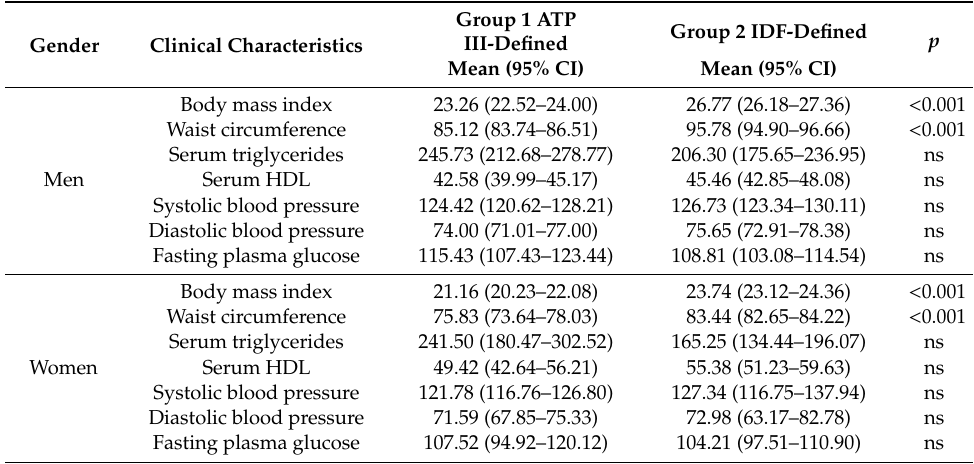
Table 4. Comparison of age-adjusted clinical characteristics of subjects with IDF-defined MetS vs. subjects with ATP III-defined MetS, by gender.